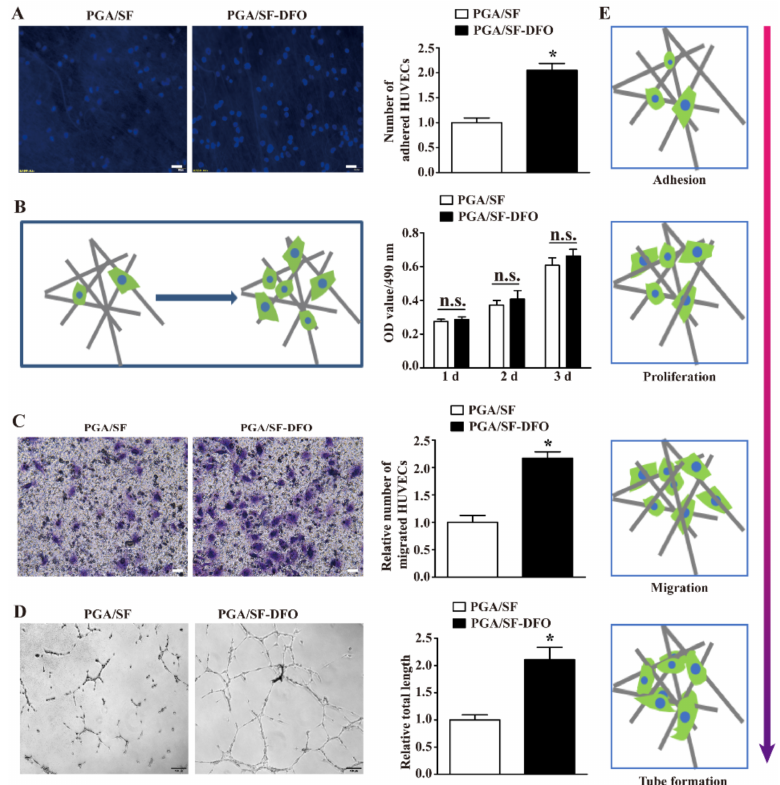
Figure 4. The effects of PGA/SF and PGA/SF-DFO scaffolds on HUVECs in vitro. ( A ) The represen- tative images and quantitative analysis of HUVECs adhesion on the PGA/SF, PGA/SF-DFO scaffolds. Scale bar = 20 µ m. ( B ) HUVECs proliferation. ( C ) HUVECs migration. Scale bar = 20 µ m. ( D ) Tube formation of HUVECs. Scale bar = 100 µ m. ( E ) Schematic illustration of adhesion, proliferation, migration, and tube formation of HUVECs in response to PGA/SF and PGA/SF-DFO scaffolds. Asterisks (*) indicate statistical significance, ( p < 0.05), and n.s. represents no significant